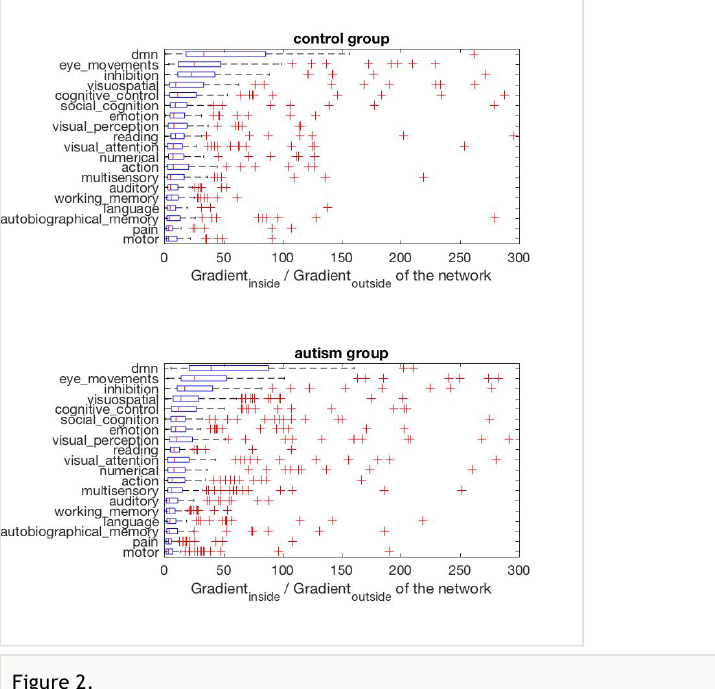
Figure 2. Goodness of fi t for principal gradient. Ranked according to the median goodness of fi t for both groups.